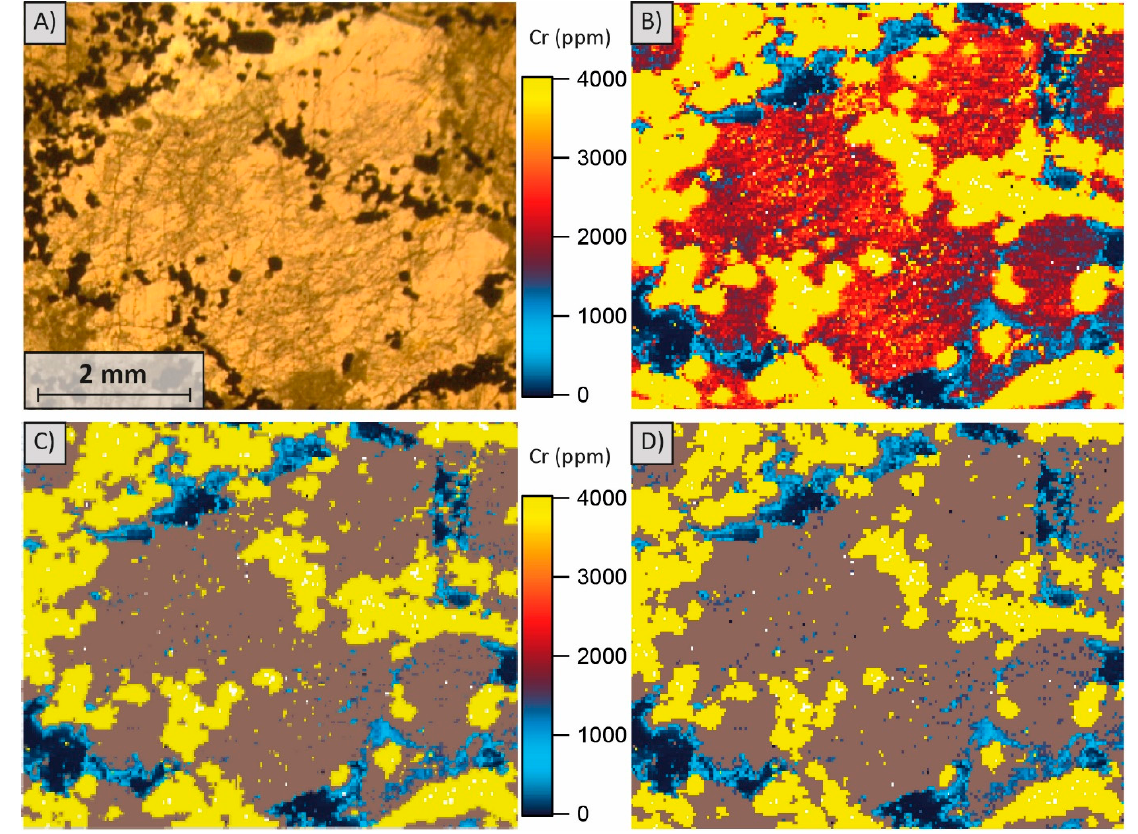
Figure 8. ( A ) Plane polarised microscope image of area 1 on sample 310.00b, Upper Split; ( B ) Semi-quantitative Cr distribution map of area 1 on sample 310.00b; ( C ) grey ROI with criteria: 1500 ppm < Cr < 4000 ppm; ( D ) grey ROI with criteria: 1500 ppm < Cr < 6000